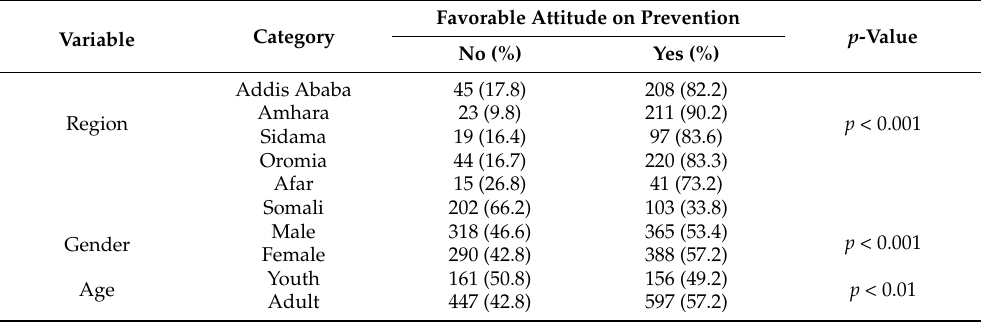
Table 5. The levels of attitudes by region, sex, and age toward COVID-19 prevention at the time of the COVID-19 hesitancy baseline survey in Ethiopia,